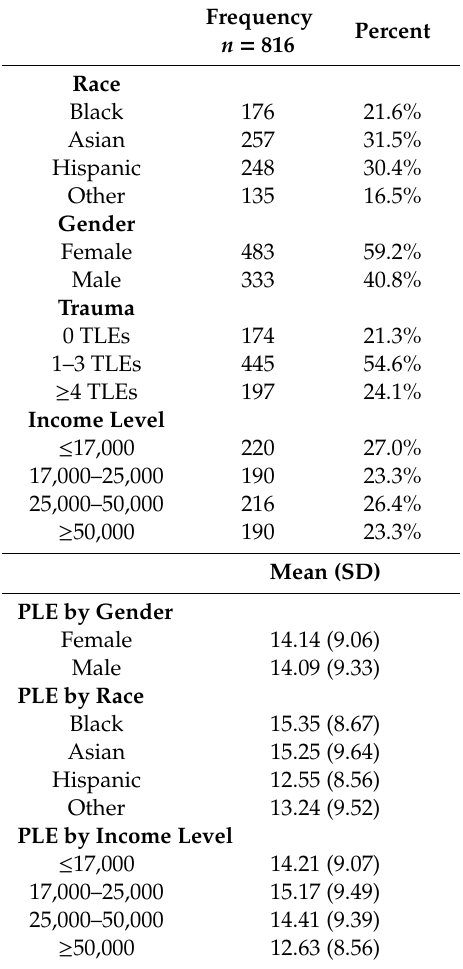
Table 1. Sample Demographics and